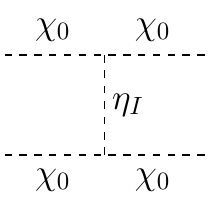
Figure 1 . Dark matter (cid:31) 0 elastic scattering by exchanging (cid:17) I